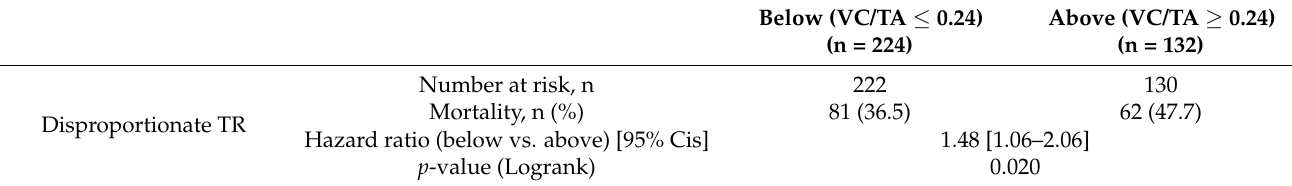
Table 5. Unstratified Kaplan–Meier estimates for overall survival at 2 years of significant or dispro- portionate